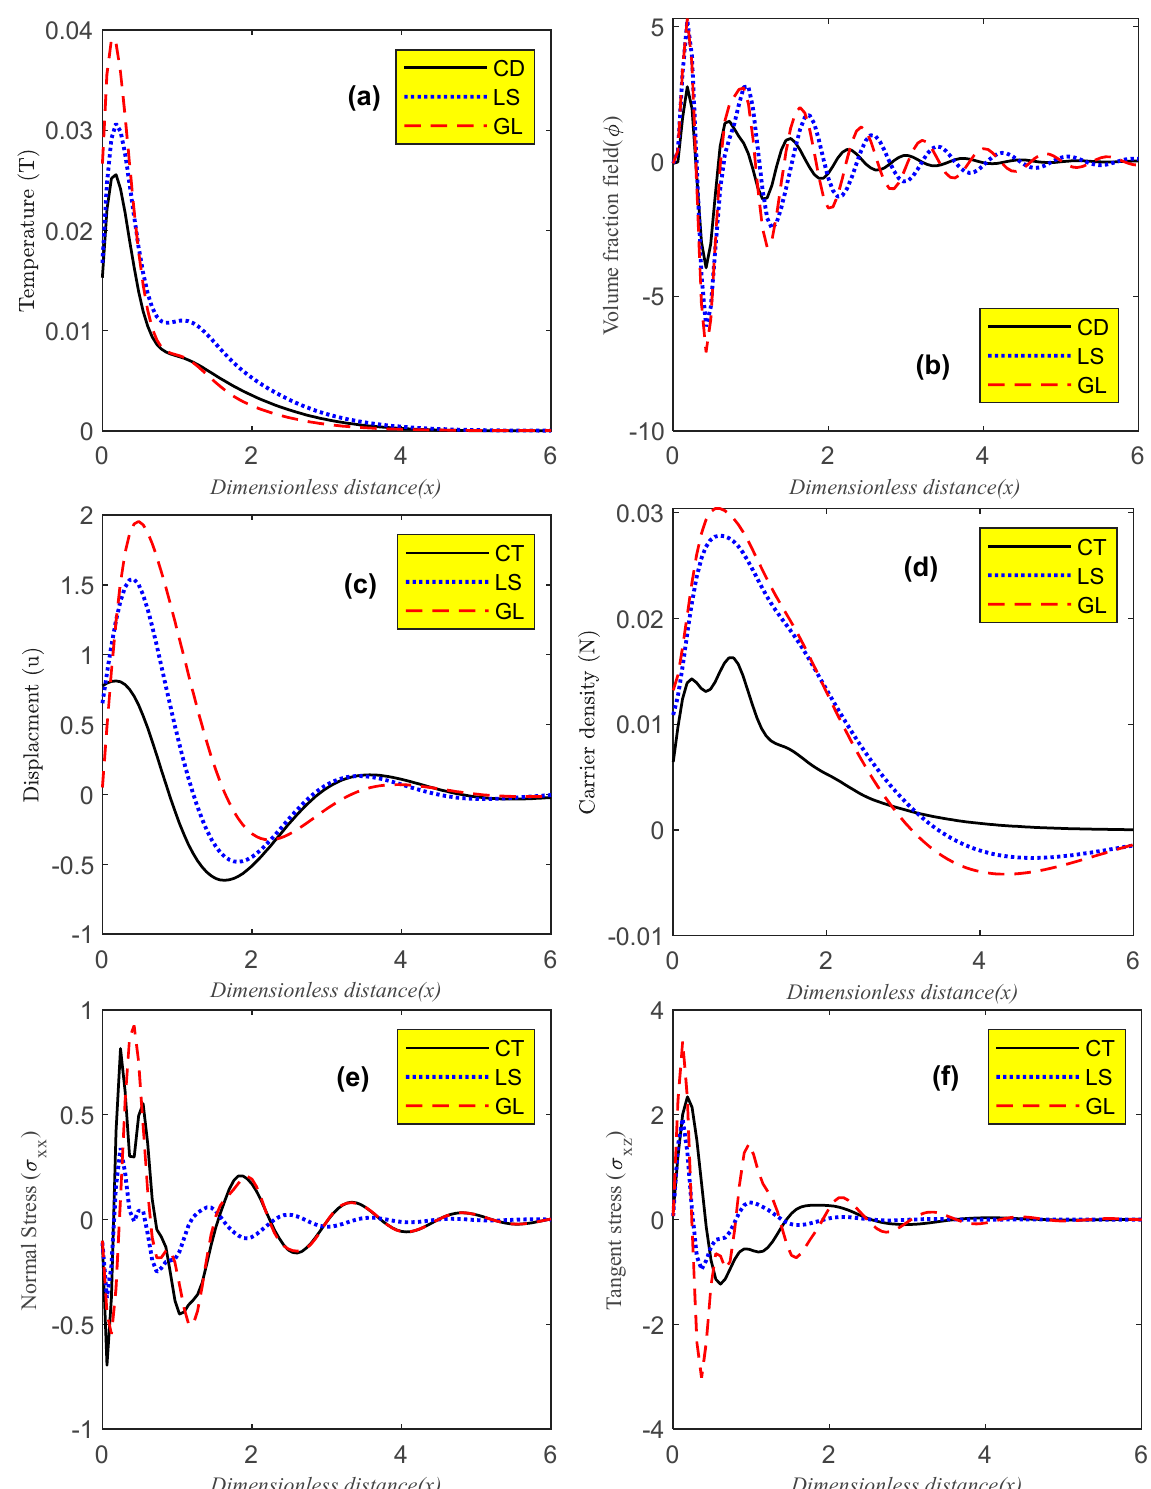
Figure 1. ( a–f ) Variation of the main physical distributions w.r.t the distance for different relaxation times under the impact of porosity parameters.